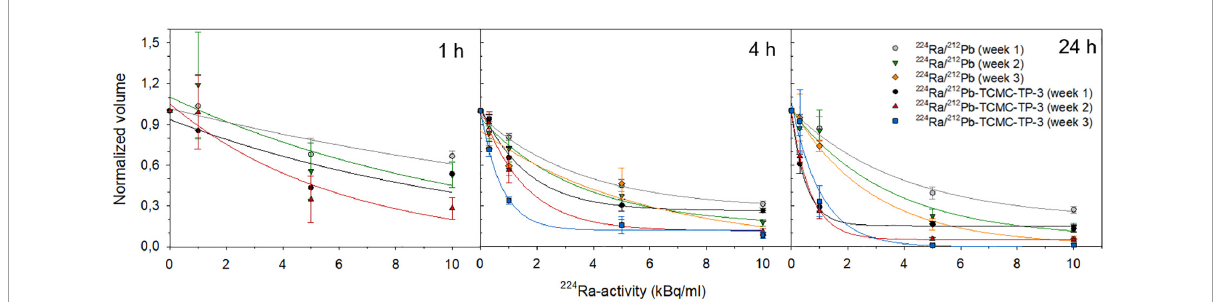
FIGURE3 Cytotoxicity of dual alpha solutions. The influence of 1, 4, or 24 h incubation of 224 Ra/ 212 Pb and 224 Ra/ 212 Pb-TCMC-TP-3 on OHS spheroid growth at increasing 224 Ra/ 212 Pb-activities. The normalized volume was calculated by dividing the volume of the treated spheroid by the